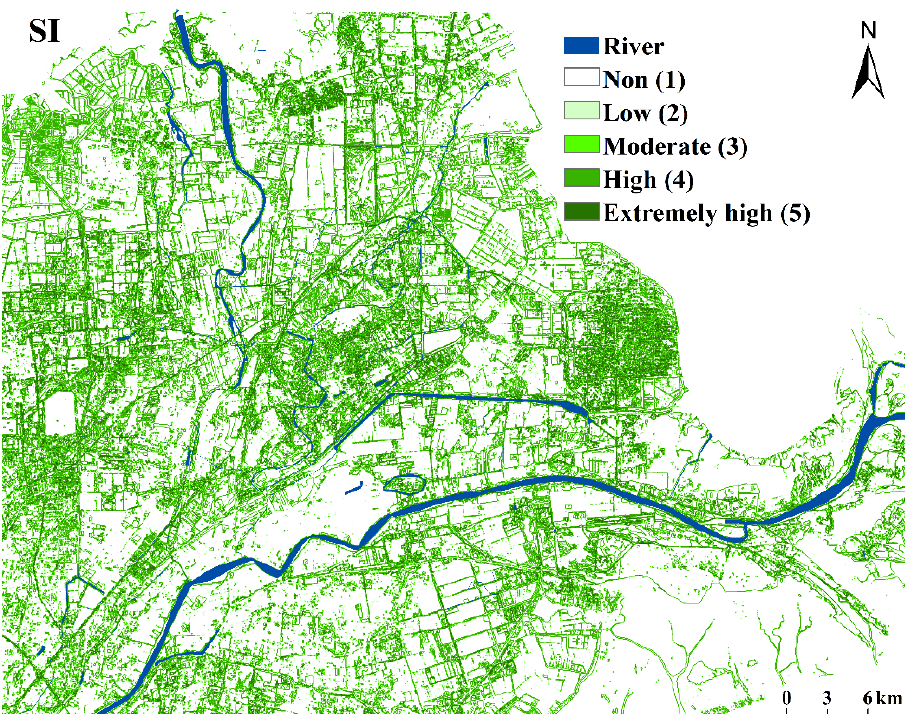
Figure 5. The spatial distribution of SI in the study area.